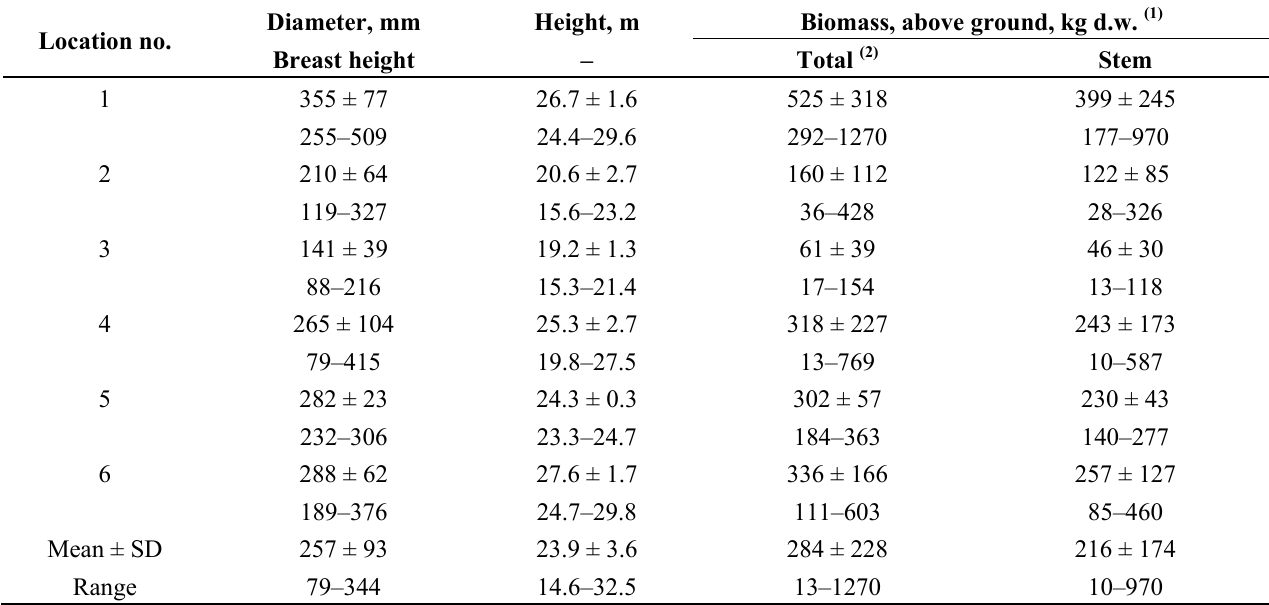
Table 2. Characteristics of poplars used in the study.